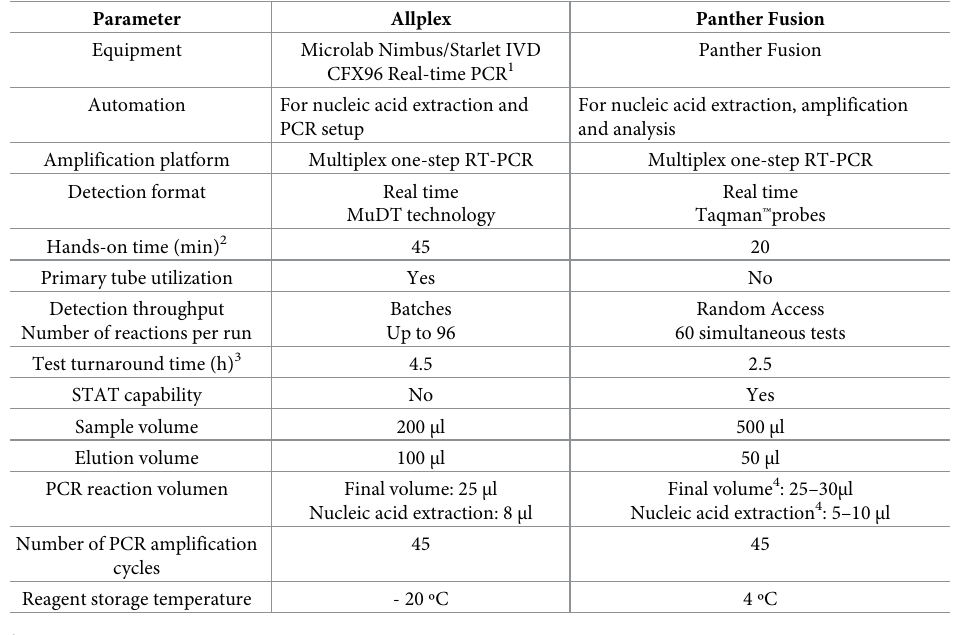
Table 1. Main characteristics of Allplex and Panther Fusion